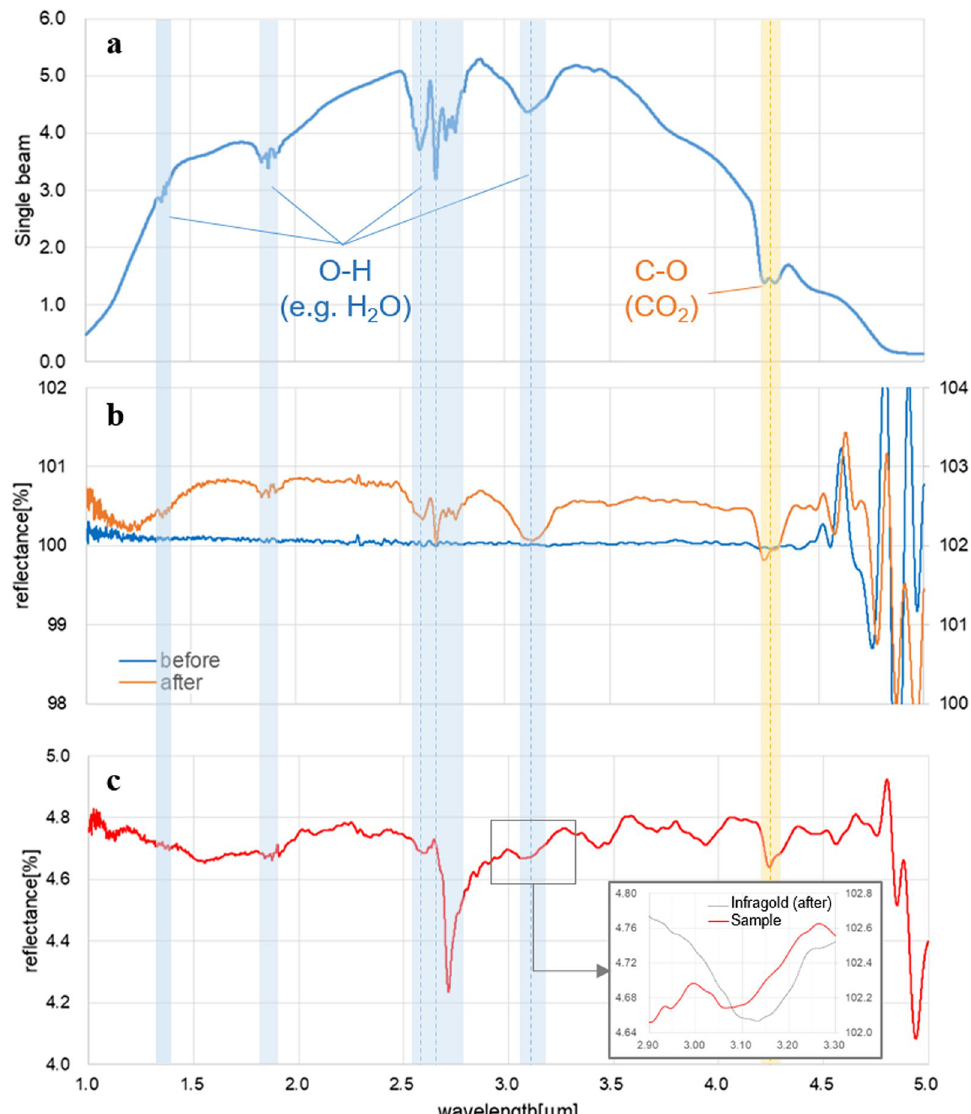
Fig. 2 Influence of absorption in atmosphere. Absorption bands of OH (1.4, 1.85, 2.6–2.8, 3.1 μm) and of CO 2 (4.2 μm) are detected in a background signal, and b Infragold spectra after the sample measurement (example of A0014). Basically no absorption band is detected in the Infragold spectra before the sample measurement. c Only CO 2 absorption is detected in the sample spectrum (example of